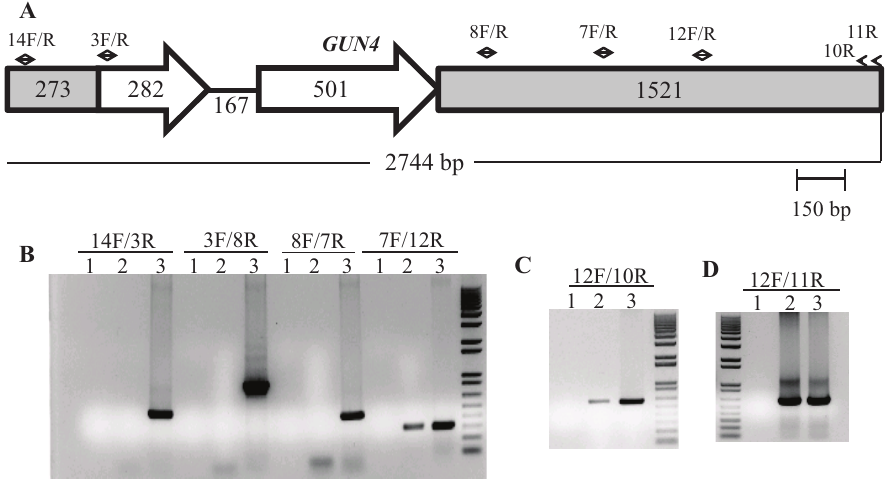
Figure S4. Genomic DNA analysis of 6F14 and 4A+. ( A ) A schematic of the GUN4 gene. Small black arrows denote GUN4 specific primers. The two GUN4 exons are represented by white block arrows. Grey boxes in GUN4 denote UnTranslated Regions (UTRs). ( B ), ( C ) and ( D ) DNA gels showing DNA products obtained from genomic DNA PCR using GUN4 specific primers. Lanes 1, 2 and 3 are the zero DNA controls, 6F14 and 4A+, respectively. PCR primer names are labeled on the top of the gel. 14F/3R gives a 517 bp product while 3F/8R gives a 942 bp product. 8F/7R gives a 449 bp product. 7F/12R gives a 313 bp product. 12F/10R gives a 606 bp product and 12F/11R gives a 623 bp product. F and R stand for forward and reverse primers, respectively. Primer sequences are shown in Table